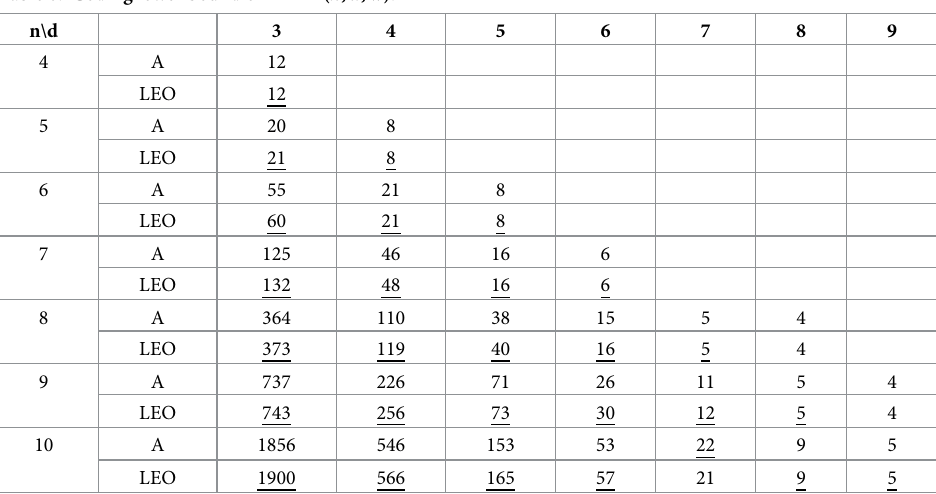
Table 6. Coding lower bound of A GC , NL ( n , d , w